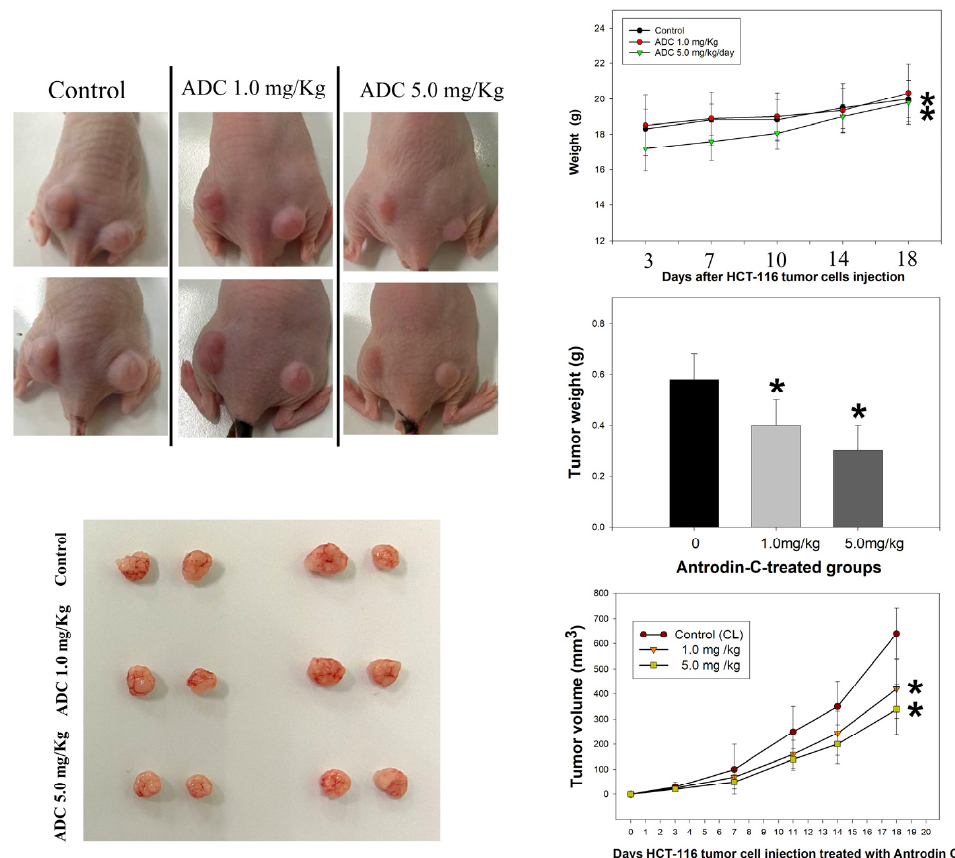
Figure 4. Antrodin C (ADC) repressed the proliferation of CRC cells in an in vivo xenograft mouse model. Subcutaneous injections with 10 6 cells/mouse for each of the indicated HCT-116 cell lines into nude mice were performed. Representative images of nude mice implanted with colorectal cancer cells, with or without ADC treatment, are shown in left panels. Right panels: after the cancer cells were implanted, the body weight, tumor volume, and tumor weight were measured at intervals of 0, 7, 10, 14, and 18 days with or without ADC treatment. The quantitative data are assayed as mean ± SD. (n = 6/group). * p <